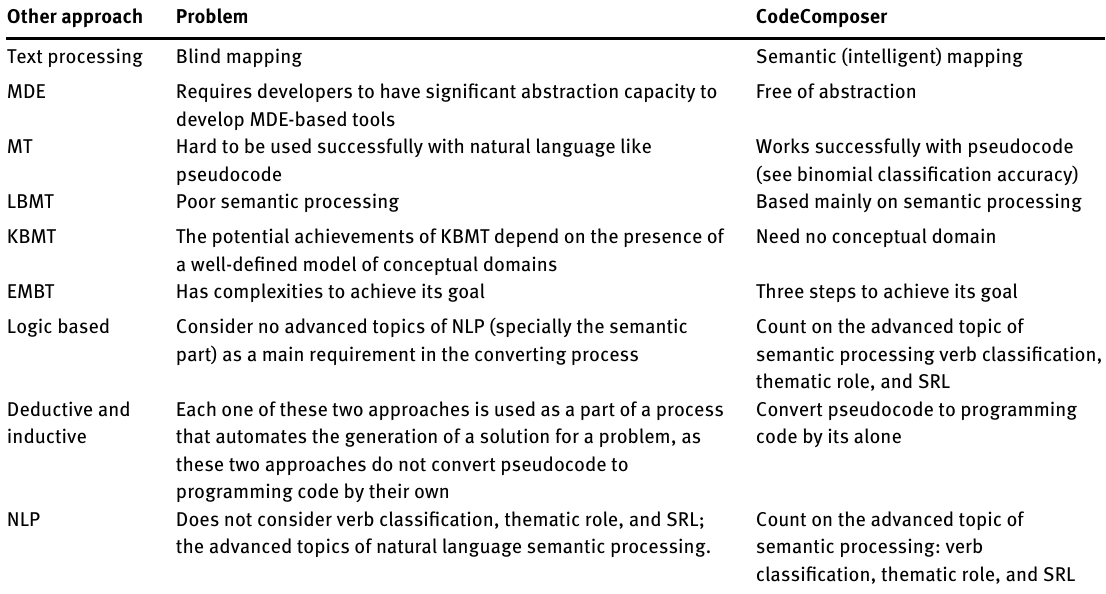
Table 8: SRL Approach Used by CodeComposer Versus Other